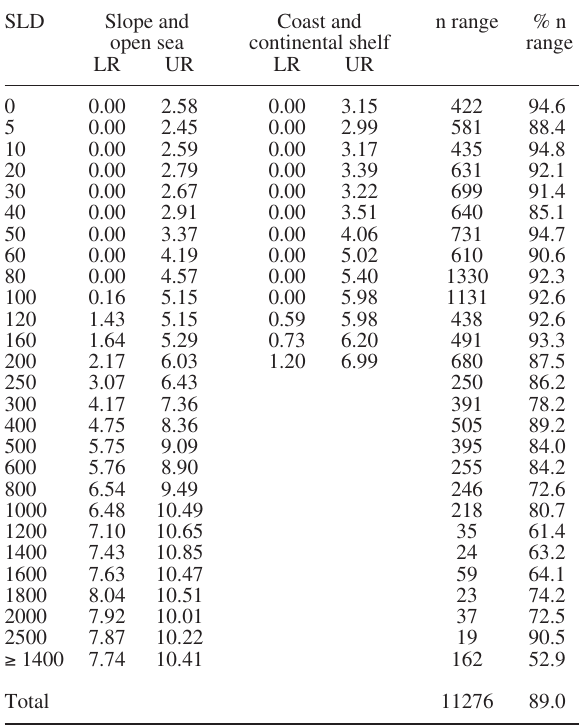
Table 14. – Silicate concentration ( m M) ranges in the NW Mediter- ranean Sea in stratified water columns (stratification coefficient = 2, 3 and 4). Headers as in Table